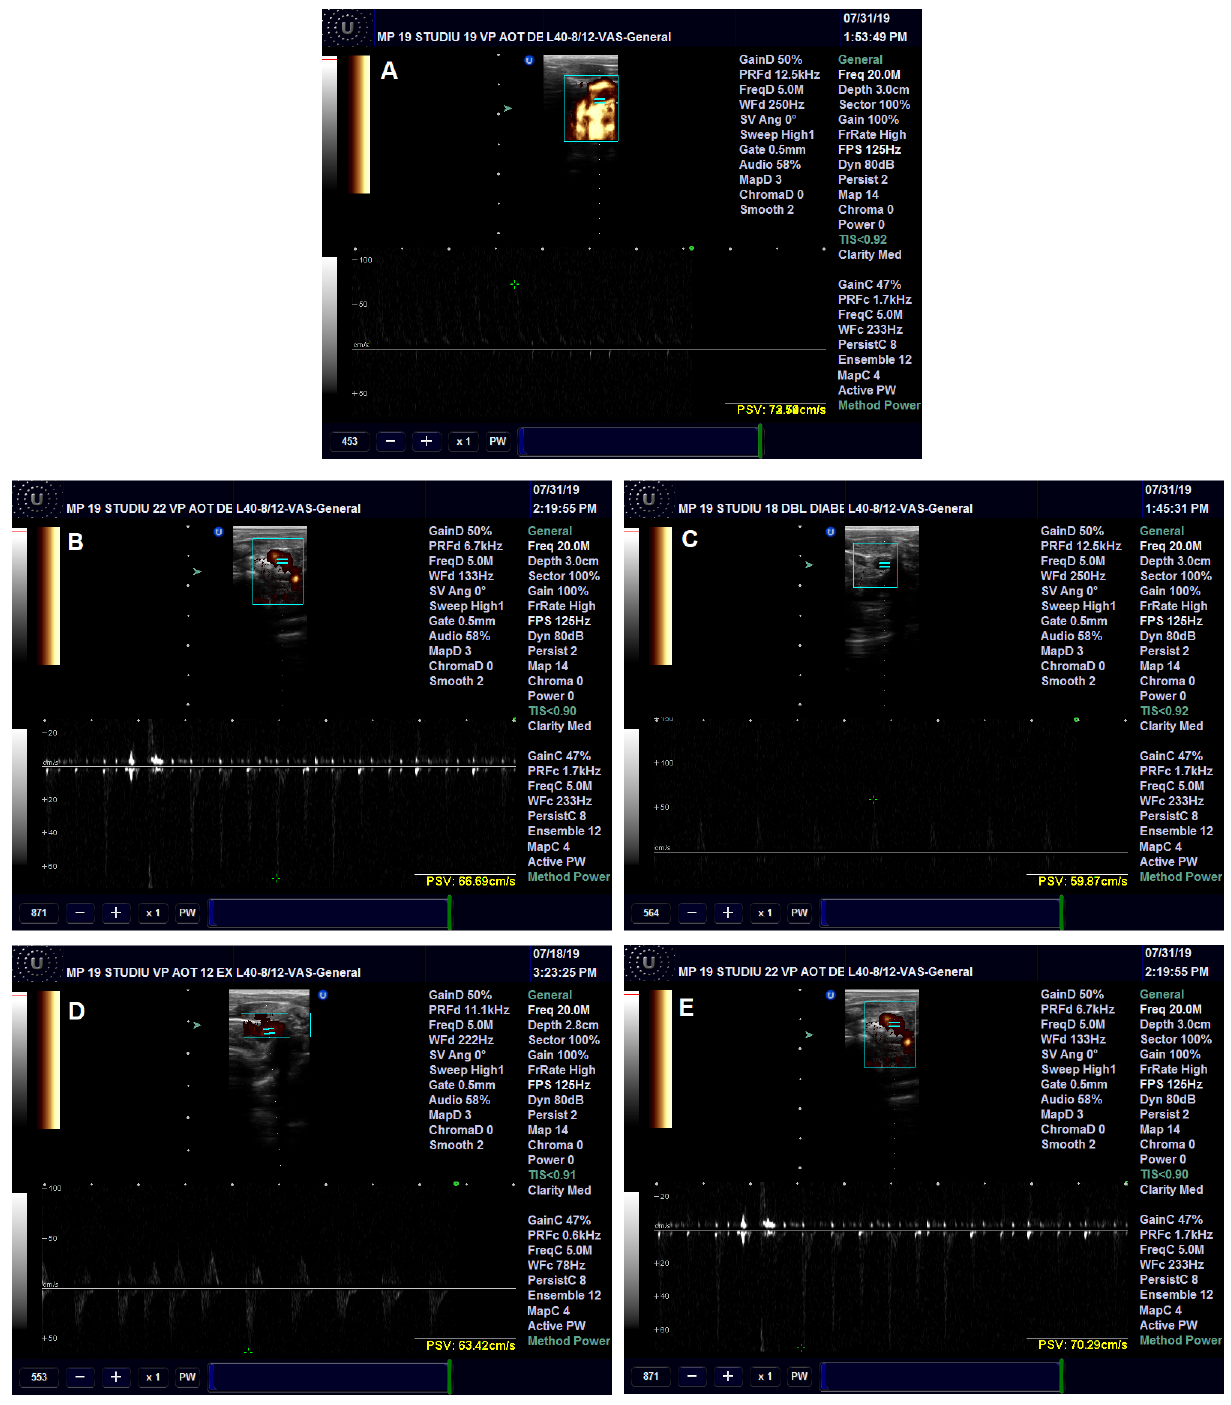
Figure 6. Blood flow in the descending aorta in rats with 9 months of HFD and the last month with experimental-induced diabetes mellitus and treatment: CMC (carboxymethylcellulose) group ( A ), Insulin group ( B ), Pioglitazone group ( C ), AuNPsCM (gold nanoparticles functionalized with Cornus mas L. extract) group ( D ) and CM ( Cornus mas ) group ( E ).